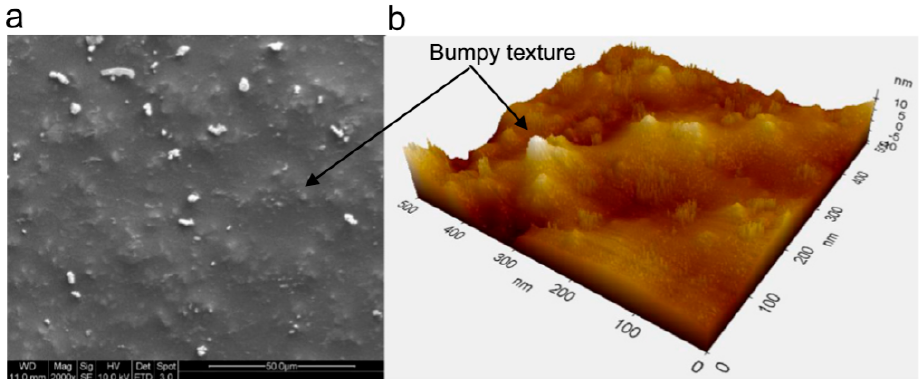
Figure 5. ( a )FESEM image of unworn surface ( b ) AFM image of same surface showing bumpy texture [26].